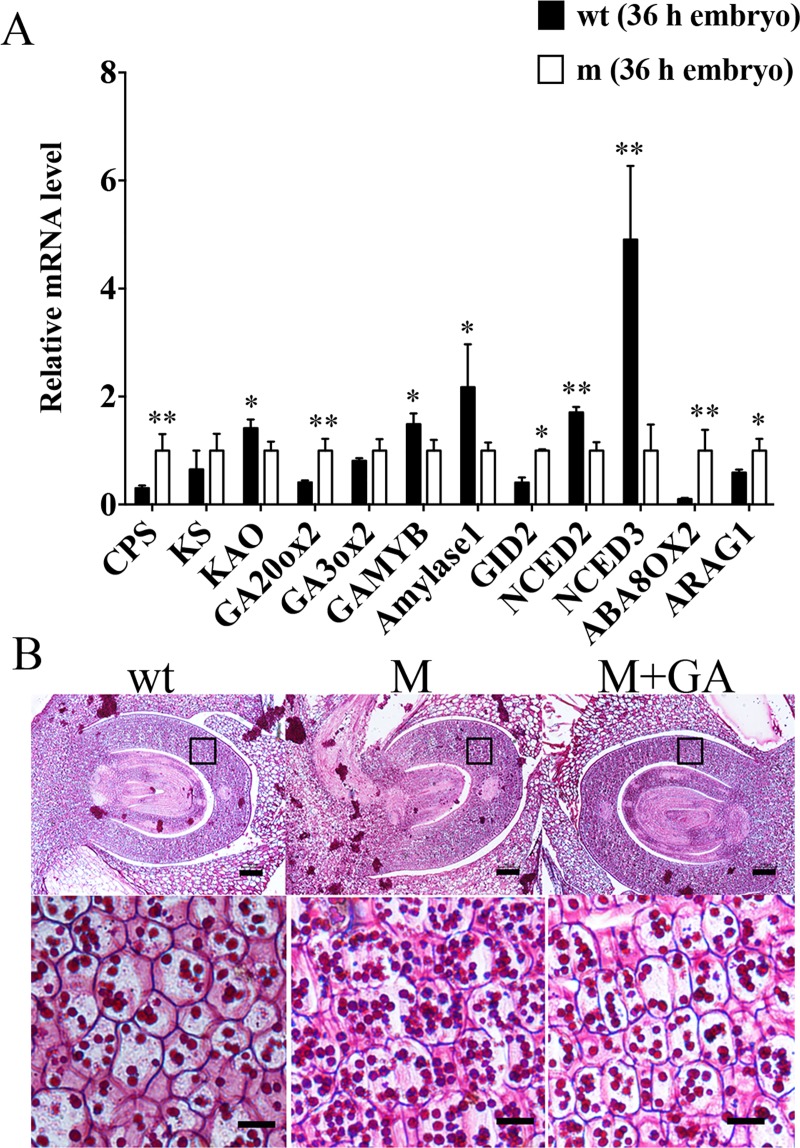
Analyses on the expression of GA and ABA metabolism and responsive genes and the degradation of starch.(A) Comparison on the expression of GA and ABA metabolism and responsive genes between the embryos from wild-type and mutant through qRT-PCR. Data are means±SE (n = 3). Significant difference was determined by Student’s t-test (*p < 0.05, **p < 0.01). (B) Microscope observation of the starch granules in the paraffin sections of rice embryos from wt, m and m treated with exogenous GA3 (m+GA). The down-side panels are the enlaged rectangle areas of their corresponding up-side panels. Bars = 15μm. All the embryos were from the seeds at 36 h after imbibition.